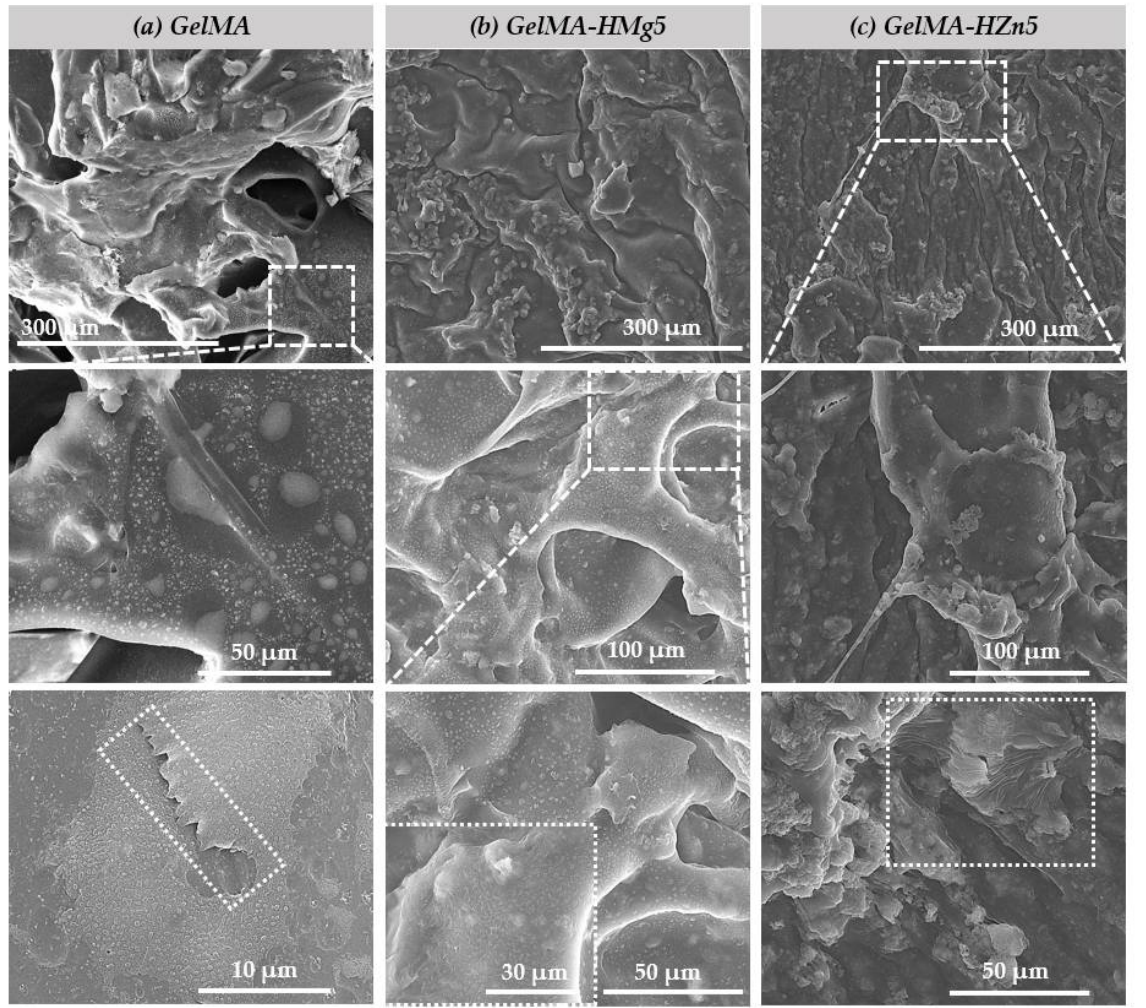
Figure 8. SEM micrographs of ( a ) gelatine methacrylate (GelMA), ( b ) gelatine methacrylate with magnesium (GelMA-HMg5) and ( c ) gelatine methacrylate with zinc (GelMA-HZn5) composites in contact with cell .